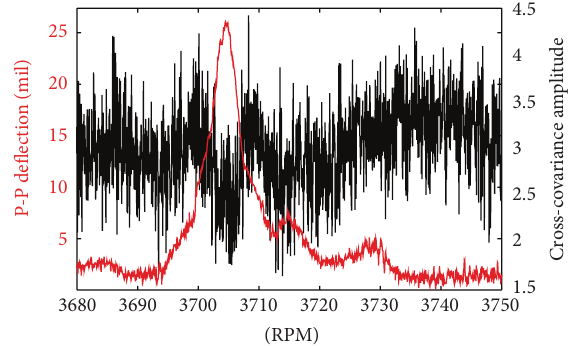
Figure 16: Cross covariance and NSMS deflection for Blade 26 at high loading (80% span).